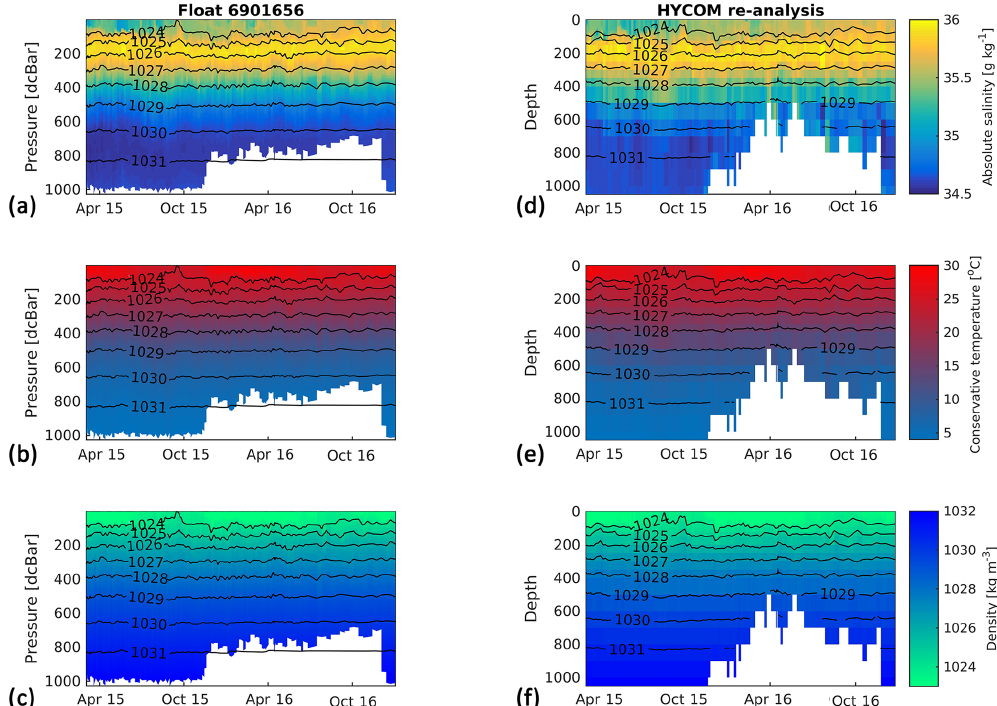
Figure C1. Profiles of (left side) float 656 and (right side) corresponding data from the HYCOM re-analysis over depth and time for (a, e) absolute salinity, (b, f) conservative temperature and (c, g) density. Every colored point corresponds to a measurement. The black lines indicate the isopycnals from 1024 to 1031kgm − 3